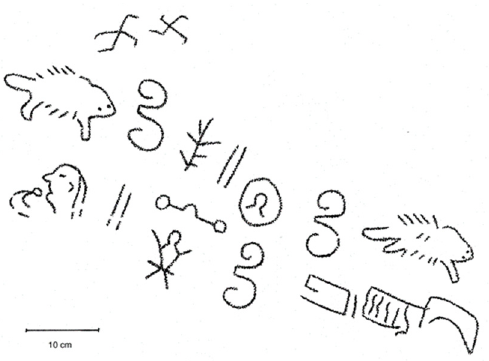
Figure 1. Western Message Petroglyphs, panel 2 at Ash Fork, Arizona (Drawing by David Lee) 1 .